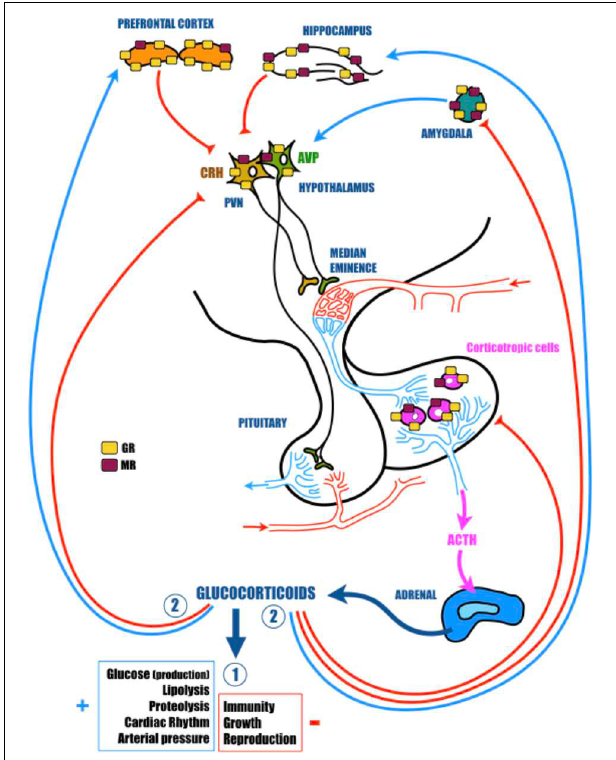
FIGURE 1 | The hypothalamic-pituitary-adrenal (HPA) axis plays a vital role in adaptation of the organism to homeostatic challenge. The activation of the HPA axis by stress leads to rapid secretion of corticotropin releasing hormone (CRH) and arginine vasopressin (AVP) from the hypothalamic paraventricular nucleus (PVN). In turn, CRH and AVP activate the secretion of adrenocorticotropic hormone (ACTH) from the anterior pituitary, which finally stimulates the release of glucocorticoids (GC; cortisol in primates and corticosterone in rodents) from the adrenal glands. CRH is principally synthesized in the parvocellular portion of the PVN where it is co-localized with AVP. AVP acts in synergy with CRH and potentiates the ability of CRH to induce ACTH secretion. AVP is largely synthesized in the other portion of the PVN, the magnocellular region. Here, this hormone is preponderantly conveyed to the posterior pituitary, where it is stocked until release into the general circulation to participate in several actions particularly related to water control. GC readily cross the blood-brain barrier and bind to low-affinity glucocorticoid receptors (GR) and high-affinity mineralocorticoid receptors (MR). These nuclear receptors are indispensable for regular cellular activity and crucial for many central nervous system functions, including learning and memory. While MR are essentially localized in the hippocampus, GR are more ubiquitous and are particularly found in the hypothalamus and in the pituitary, but also in several structures of the limbic system (prefrontal cortex, hippocampus, and amygdala), which are highly involved in cognitive and psychological functions. All of these cerebral regions are important components of the neural circuitry mediating HPA axis activity. Indeed, while hippocampus and prefrontal cortex exert a tonic inhibition, amygdala stimulates hypothalamic neurons. In fact, though structural plasticity in hippocampus and prefrontal cortex might mediate cognitive impairment caused by severe stress, changes in amygdala are more likely to contribute to the affective aspect of stress disorders. In response to homeostatic challenge, GC stimulate in a first time (Circle 1) all physiological functions necessary to induce an adapted response to the stress (cardiovascular and metabolic) and inhibit all functions non-immediately necessary (immunity, reproduction, and growth). In a second time (Circle 2), to avoid a runaway of the HPA axis, GC exert a negative feedback at all levels of the axis (limbic, hypothalamic, and